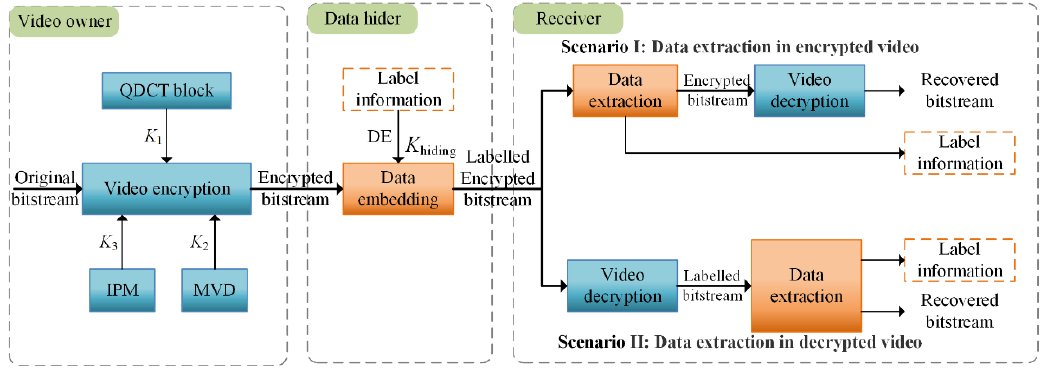
Figure 2. Scheme flow.